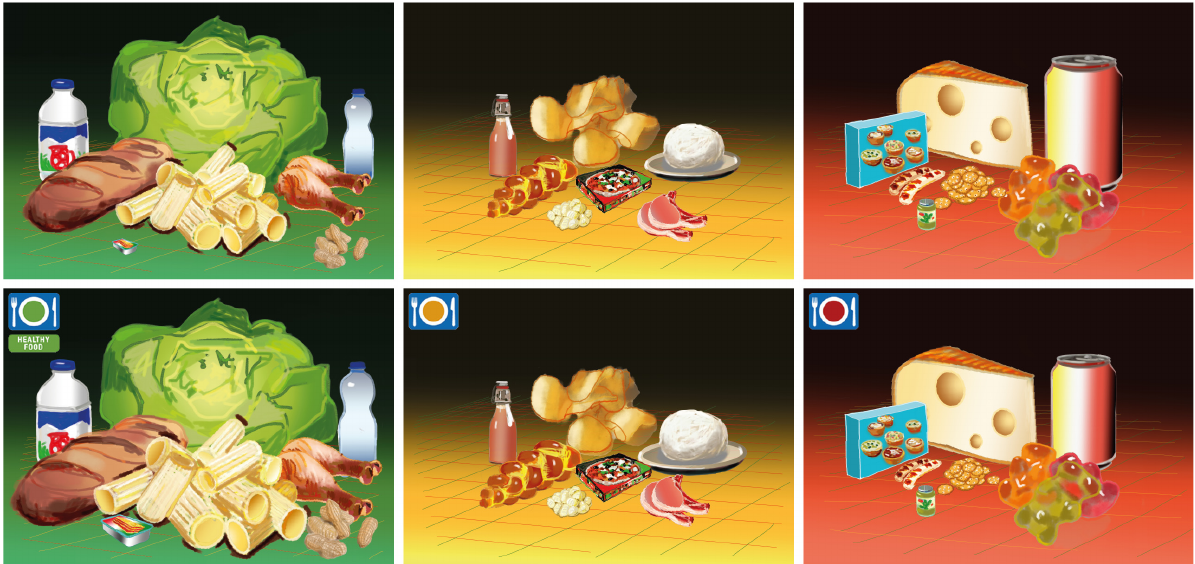
Figure 4. Illustration of the foods purchased in a comparison of the HFL vs. control. This is a “still life” illustration of the number of products purchased in each category, separated by their healthiness (e.g., green table = healthy). Sizes illustrate how many products were purchased in the category. For example, the chicken leg represents all healthy meats purchased by its size, and the bratwurst represents unhealthy meats purchased. Illustrations were created by Ulrich Binder and Simon Truffer.